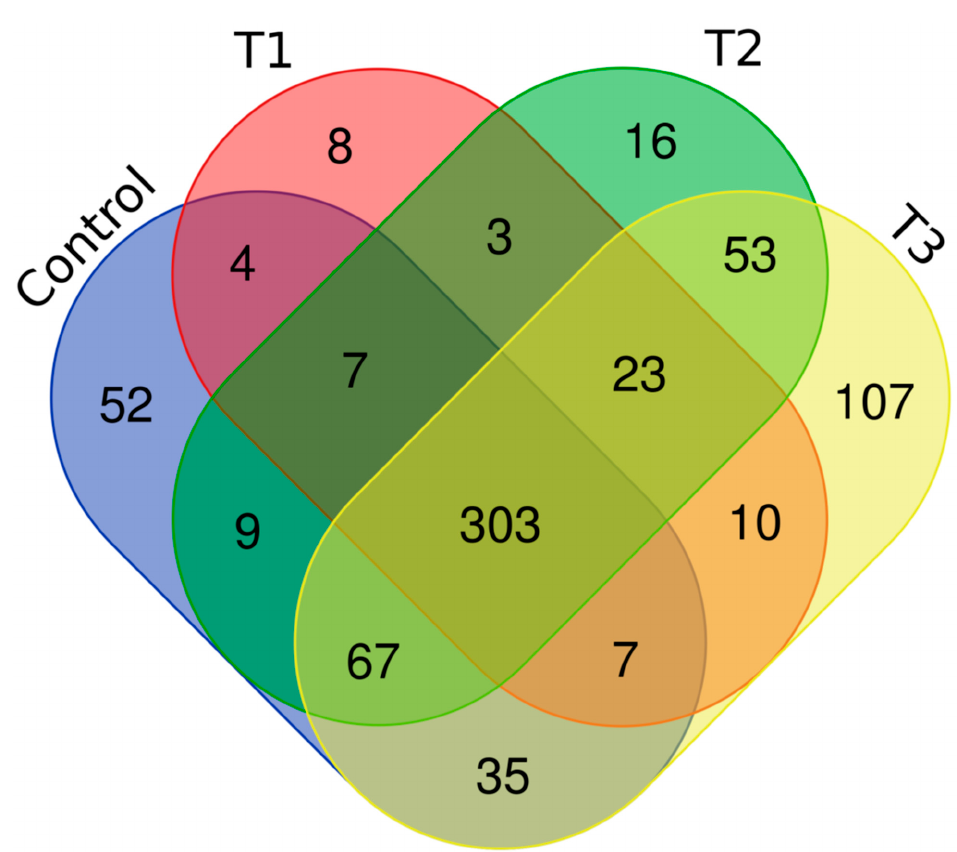
Figure 5. Venn diagram of the proteomic data in S. epidermidis strain RP62A biofilms. T1: 1/8 MIC, T2: 1/4 MIC, T3: 1/2 MIC.